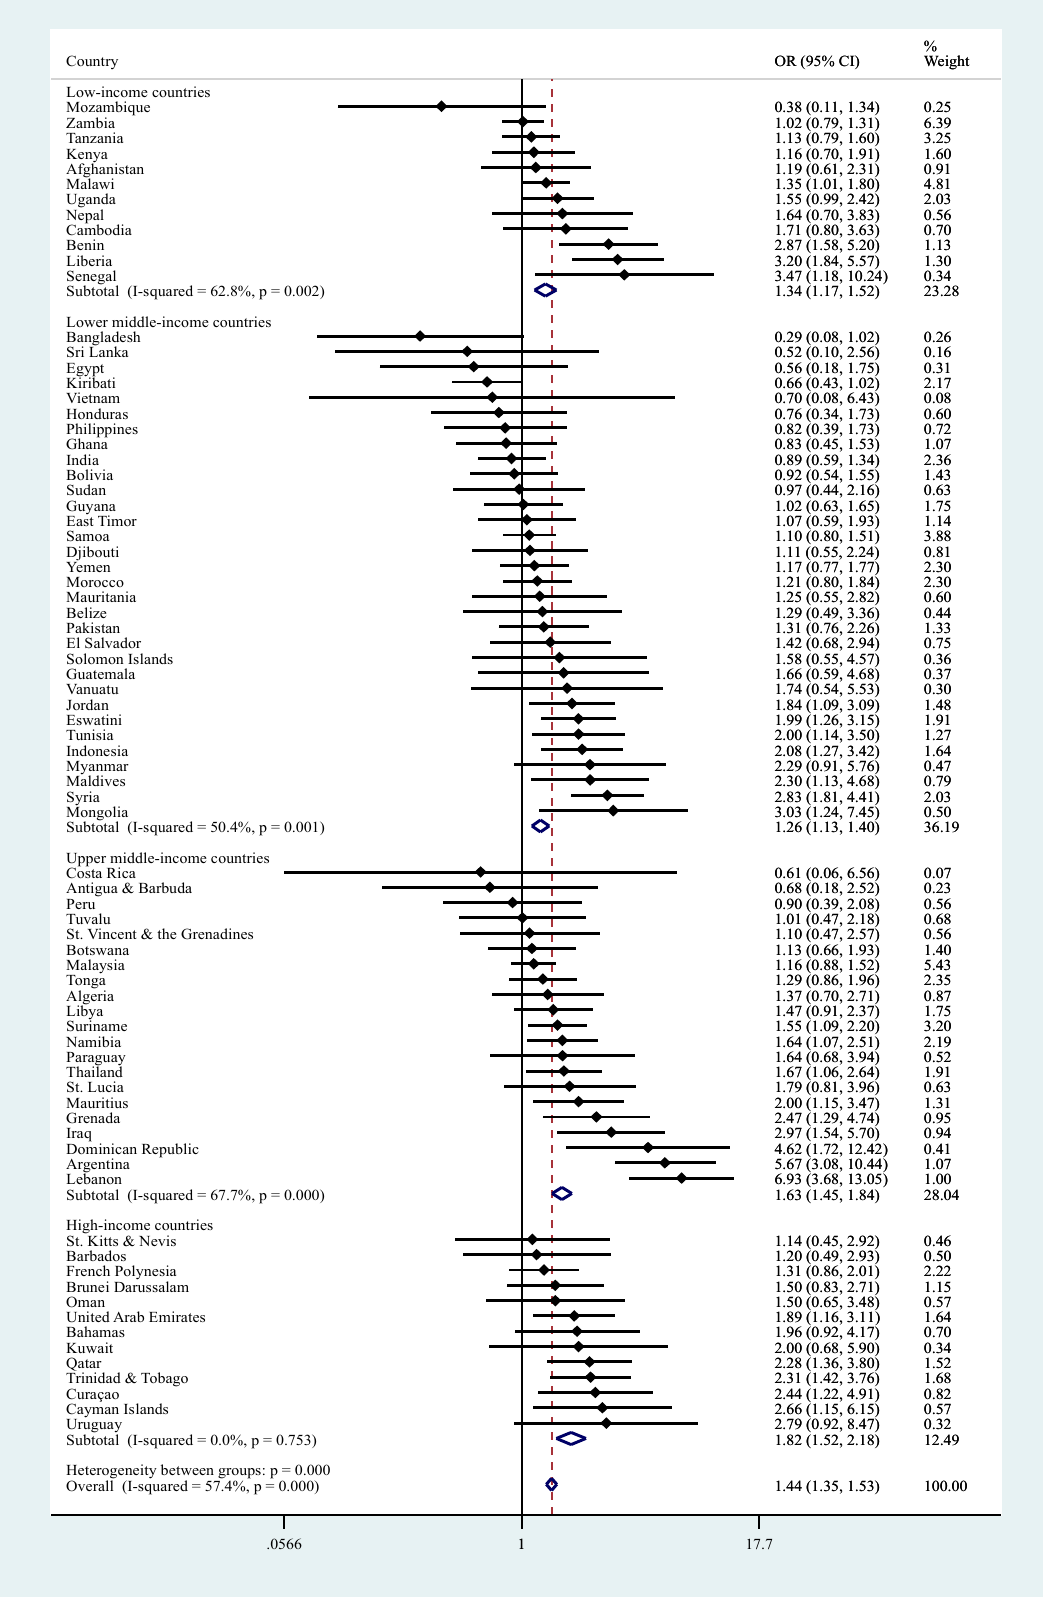
Figure A3. Country-wise association between severe food insecurity and never/rarely using soap when washings hands estimated by multivariable logistic regression adjusted for age and sex; Abbreviation: OR Odds ratio; CI Confidence interval; overall estimates were calculated by meta-analysis with random effects.